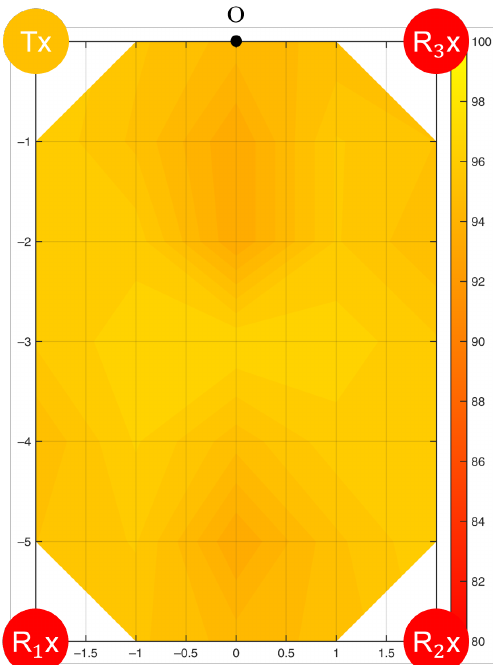
Figure 13. Accuracy contour (%) in detecting the frequency of resting tremor by multiple WiFi links. For the duration of motion, the highest sensing accuracy was 97.0% at Point 11, the lowest was 93.5% at Point 13, and the average was 95.7%, with a standard deviation of 0.86%. The filled accuracy contours are shown in Figure 14. Additionally, the sensing accuracy improved by 1.8% on average.